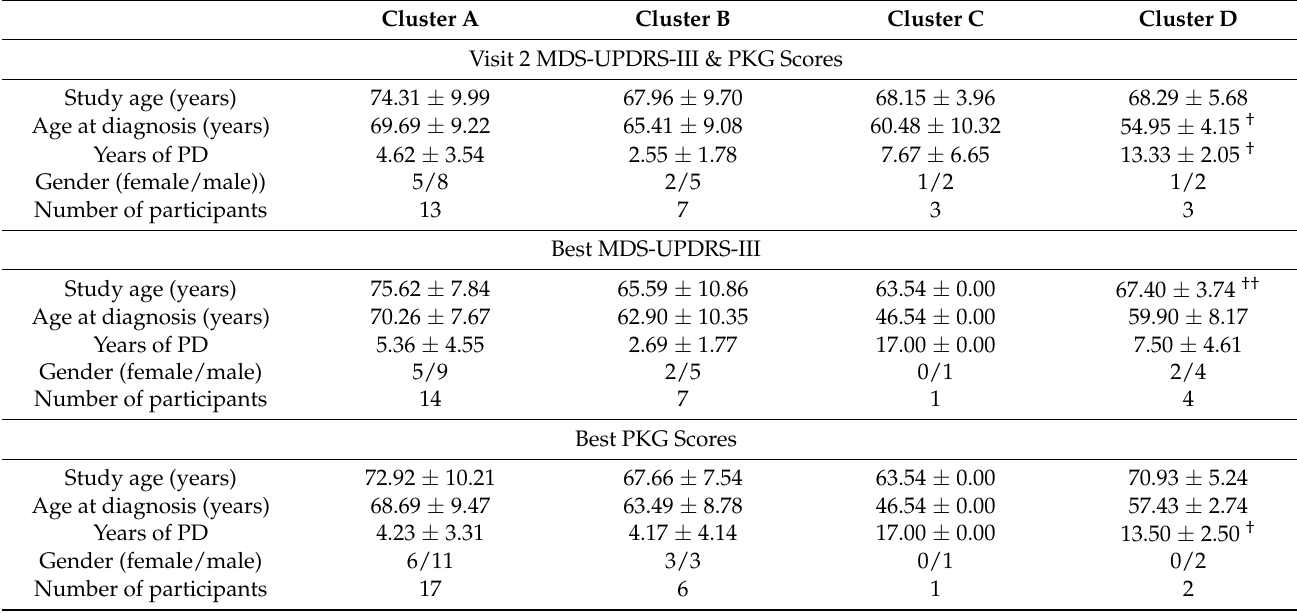
Table 2. Demographic and clinical information for clusters depicted in Figure 3a–d.